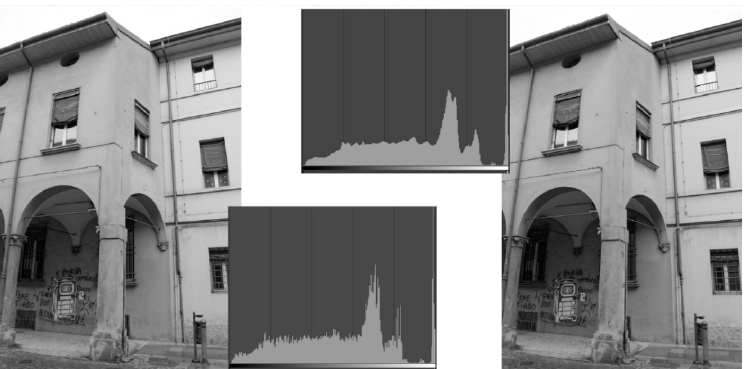
Figure 6. A comparison between Matlab RGB2GRAY ( left ) and BID ( right ) that shows a smoother histogram.